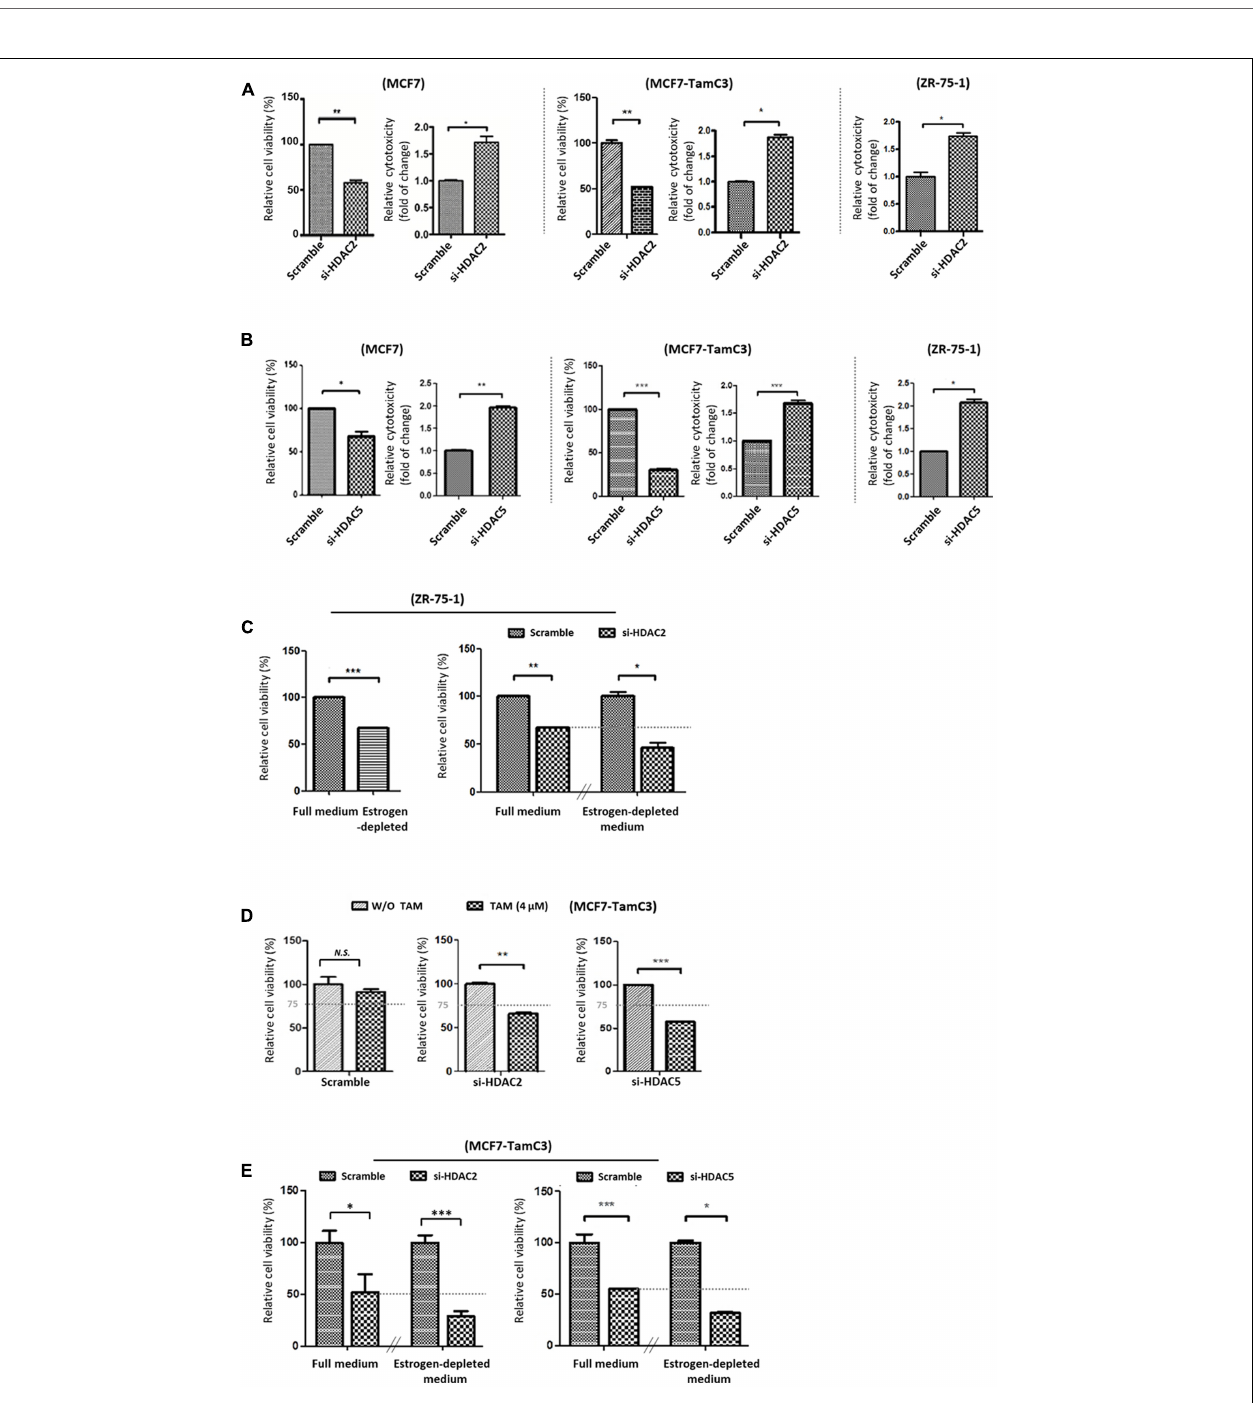
Frontiers in Pharmacology |